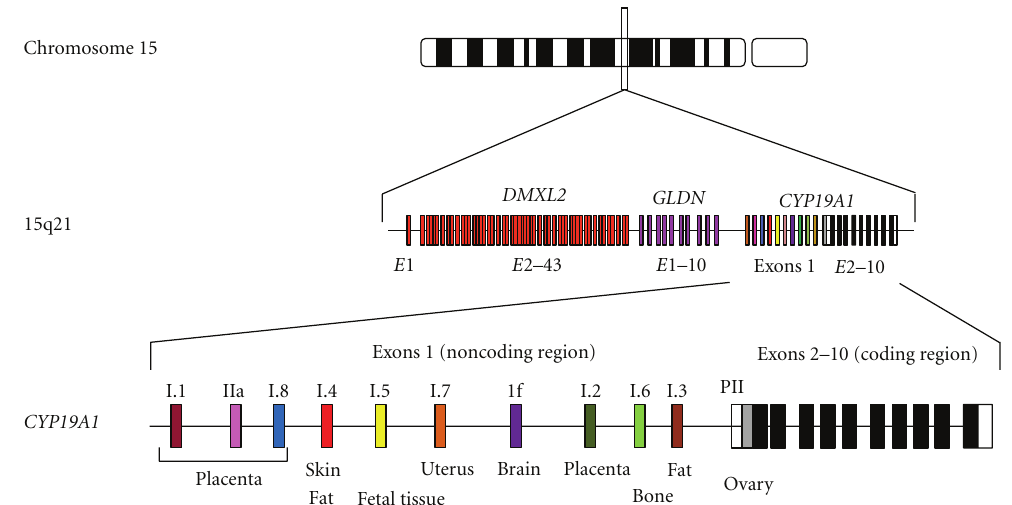
Figure 1: Simplified schematic representation indicating the genomic structure of CYP19A1 . CYP19A1 is located on 15q21.2 adjacent to DMXL2 and GLDN and consists of at least 11 noncoding exons 1 and nine coding exons 2–10 [9, 10]. Each exon 1 is accompanied by a tissue-specific promoter and is spliced alternatively onto a common splice acceptor site at exon 2